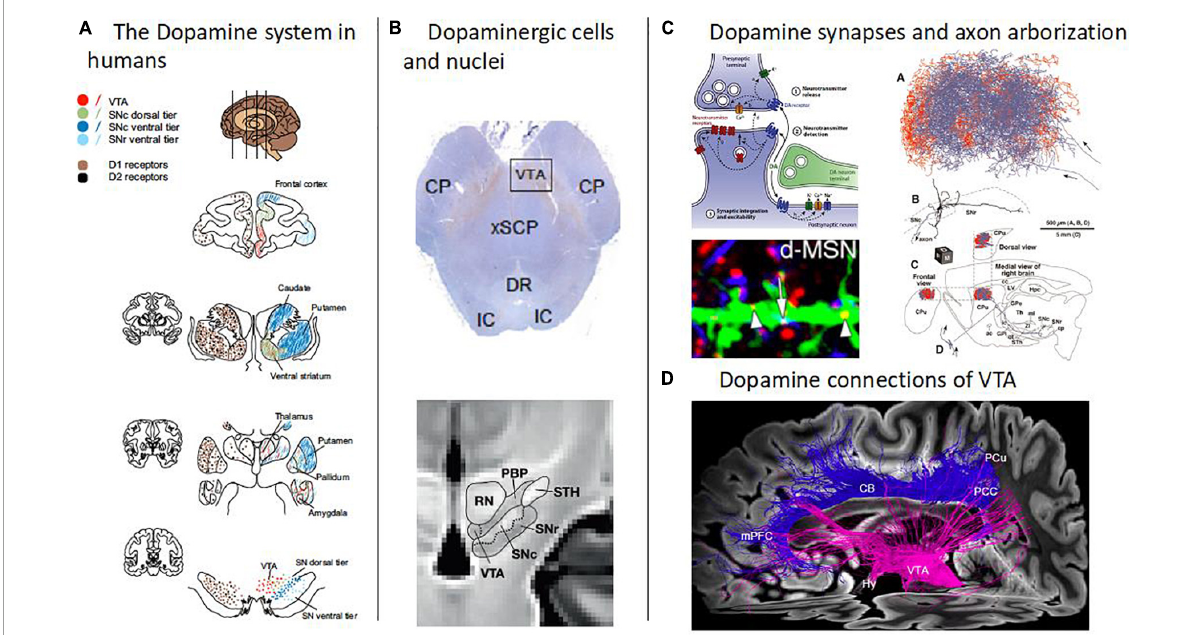
FIGURE1 Overview of the human dopamine system. (A) The dopamine system in humans. Schematic depiction of the human brain’s dopamine system, captured by the distribution of both dopamine cell bodies in the midbrain, i.e., in substantia nigra pars compacta (SNc) and ventral tegmental area (VTA), and dopamine D1 and D2 receptors mainly in striatum and frontal cortices (adapted with permission from 12). Note the topographic arrangement of dopamine projections, indicated by the same colors at different levels of the dopamine system. (B) Dopaminergic cells and nuclei. Top: Dopaminergic cells in the midbrain (Tyrosine hydroxylase immunostaining) [adapted with permission from (168)]. Bottom: Boundaries between the red nucleus (RN), parabrachial pigmented nucleus (PBP), substantia nigra (SNc and SNr), and subthalamic nucleus, overlaid on a T1w template of midbrain MRIs with isotropic voxel size of 700 µ m [adapted from (158), open-access]. (C) Dopamine synapses and axon arborization in mice. Top left: Scheme of the modulatory nature of dopamine synapses [adapted with permission from (13)]. Bottom left: Lattice-like, volume-focused distribution of dopamine synapses in the striatum of mice [adapted with permission from (14)]. Right: Dopamine axon arborization in the striatum of mice [adapted from (169), open-access]. (D) Dopamine connections of VTA. Diffusion-weighted MRI-based tractography of human VTA into the cortex [adapted with permission from